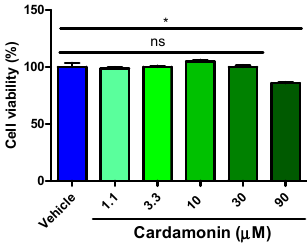
Figure 6. The effect of cardamonin on HEK293 cell viability. The cells were incubated with or without of cardamonin for 24 h. Cell viability was determined by Cell Titer-Glo assay. Data represent mean ± SEM, n = 3. ns, no significant differences, * p < 0.05, compared with vehicle control by one-way ANOVA analysis.